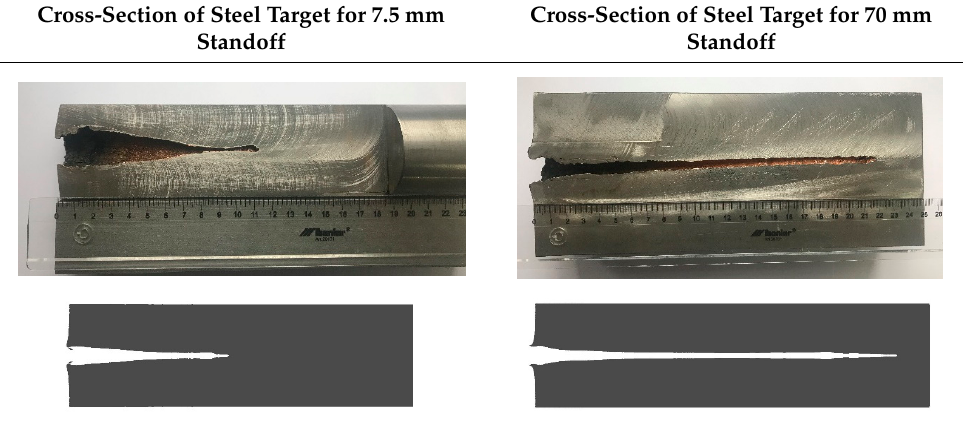
Table 6. View of the section of the steel block after shooting with the shaped charge for experi- mental and numerical tests. Cross-section of steel target for 7.5 mm standoff